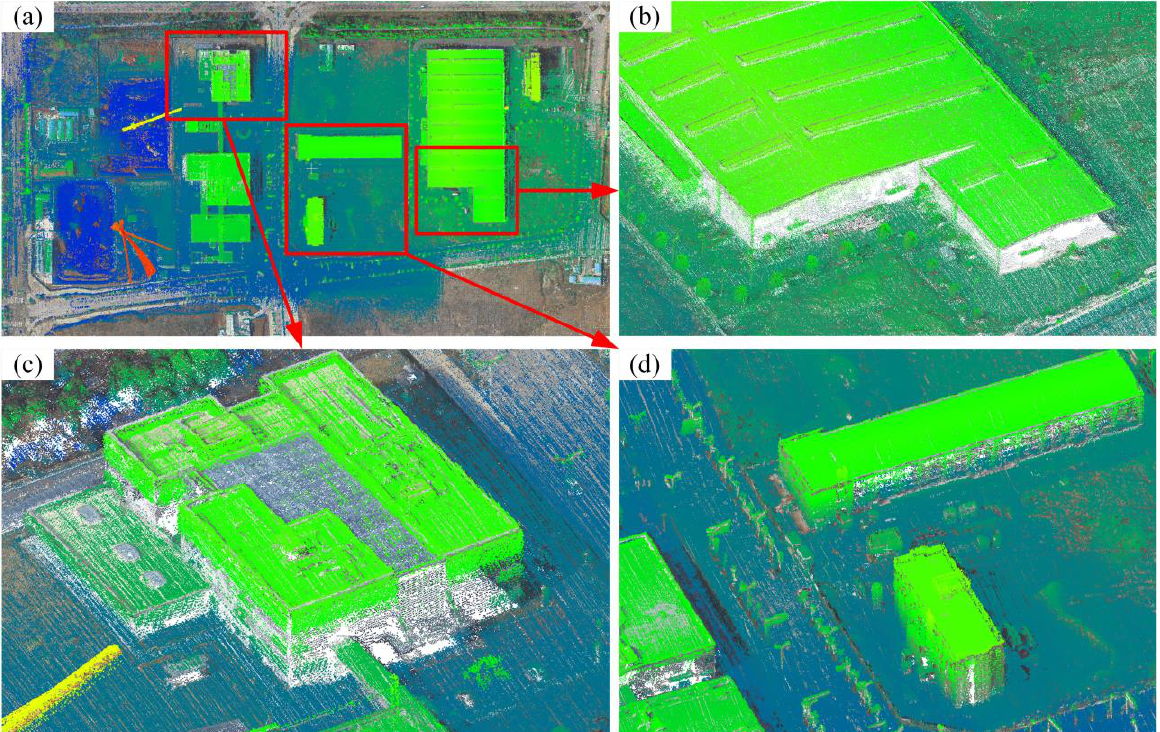
Fig.8. Accurate alignment between the laser point clouds and AT point clouds. The ULS point cloud is rendered by height. The AT point cloud is rendered by true color. (a) Top view of the whole study site. (b), (c), and (d) Details of the alignment.